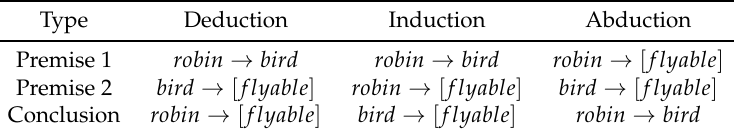
Table 1. Sample steps of basic syllogistic